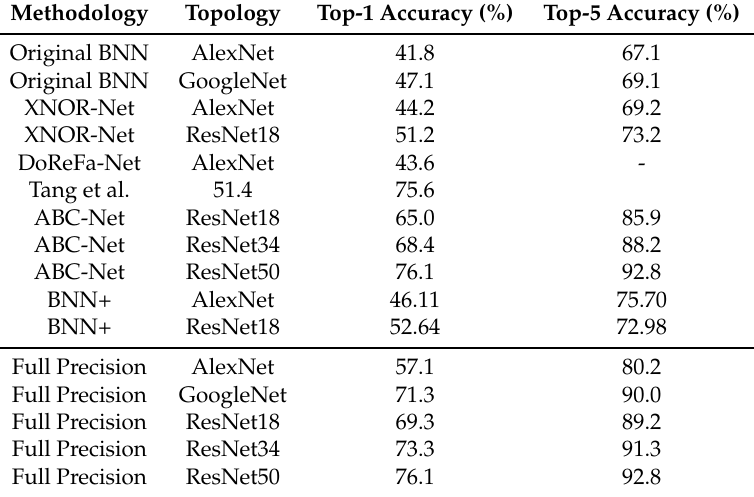
Table 3. Comparison of accuracies on the ImageNet dataset from works presented in this section. Full precision network accuracies are included for comparison as well.